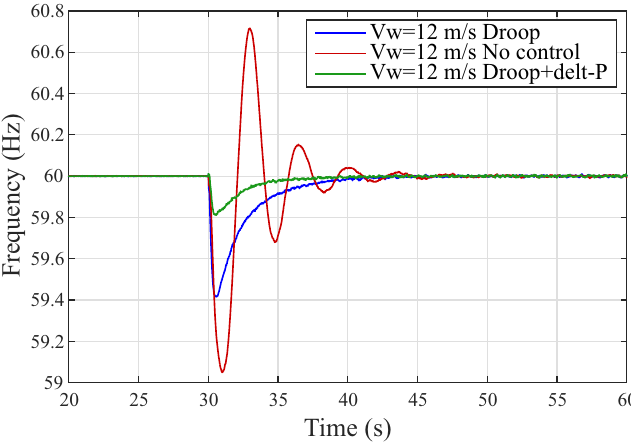
Figure 11. Frequency comparison for wind speed of 12 m/s.